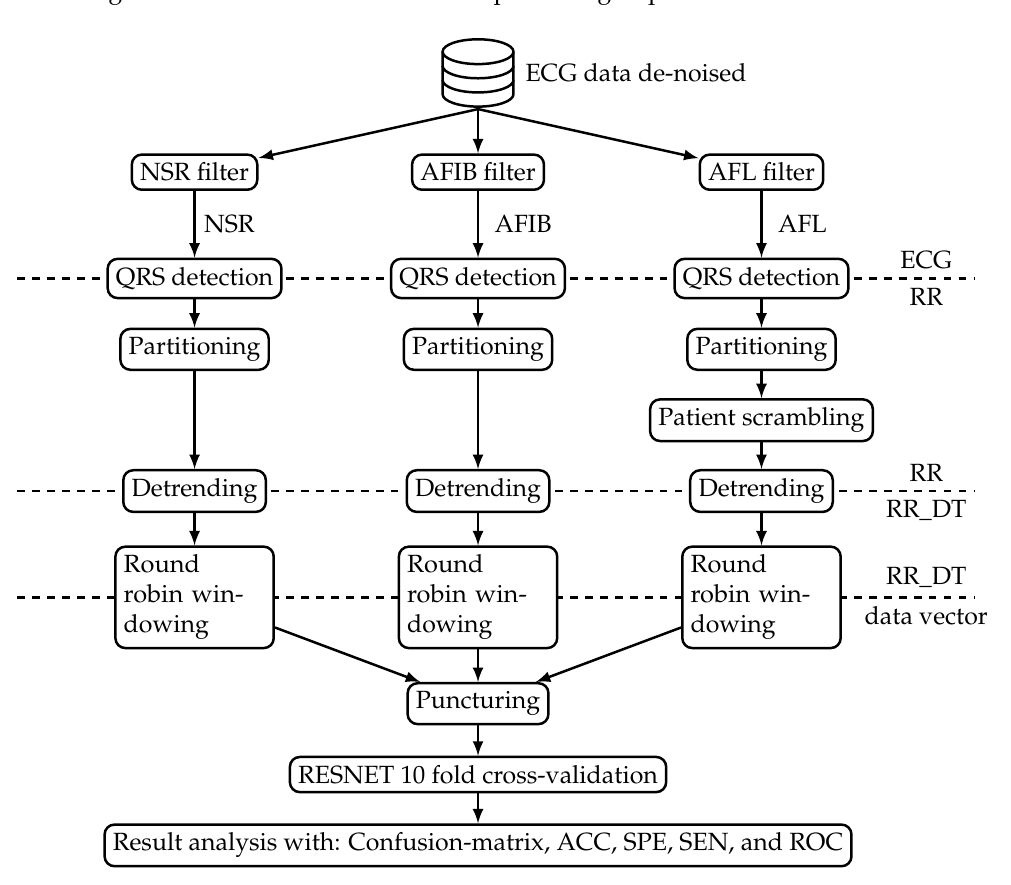
Figure 1. Block diagram of the study